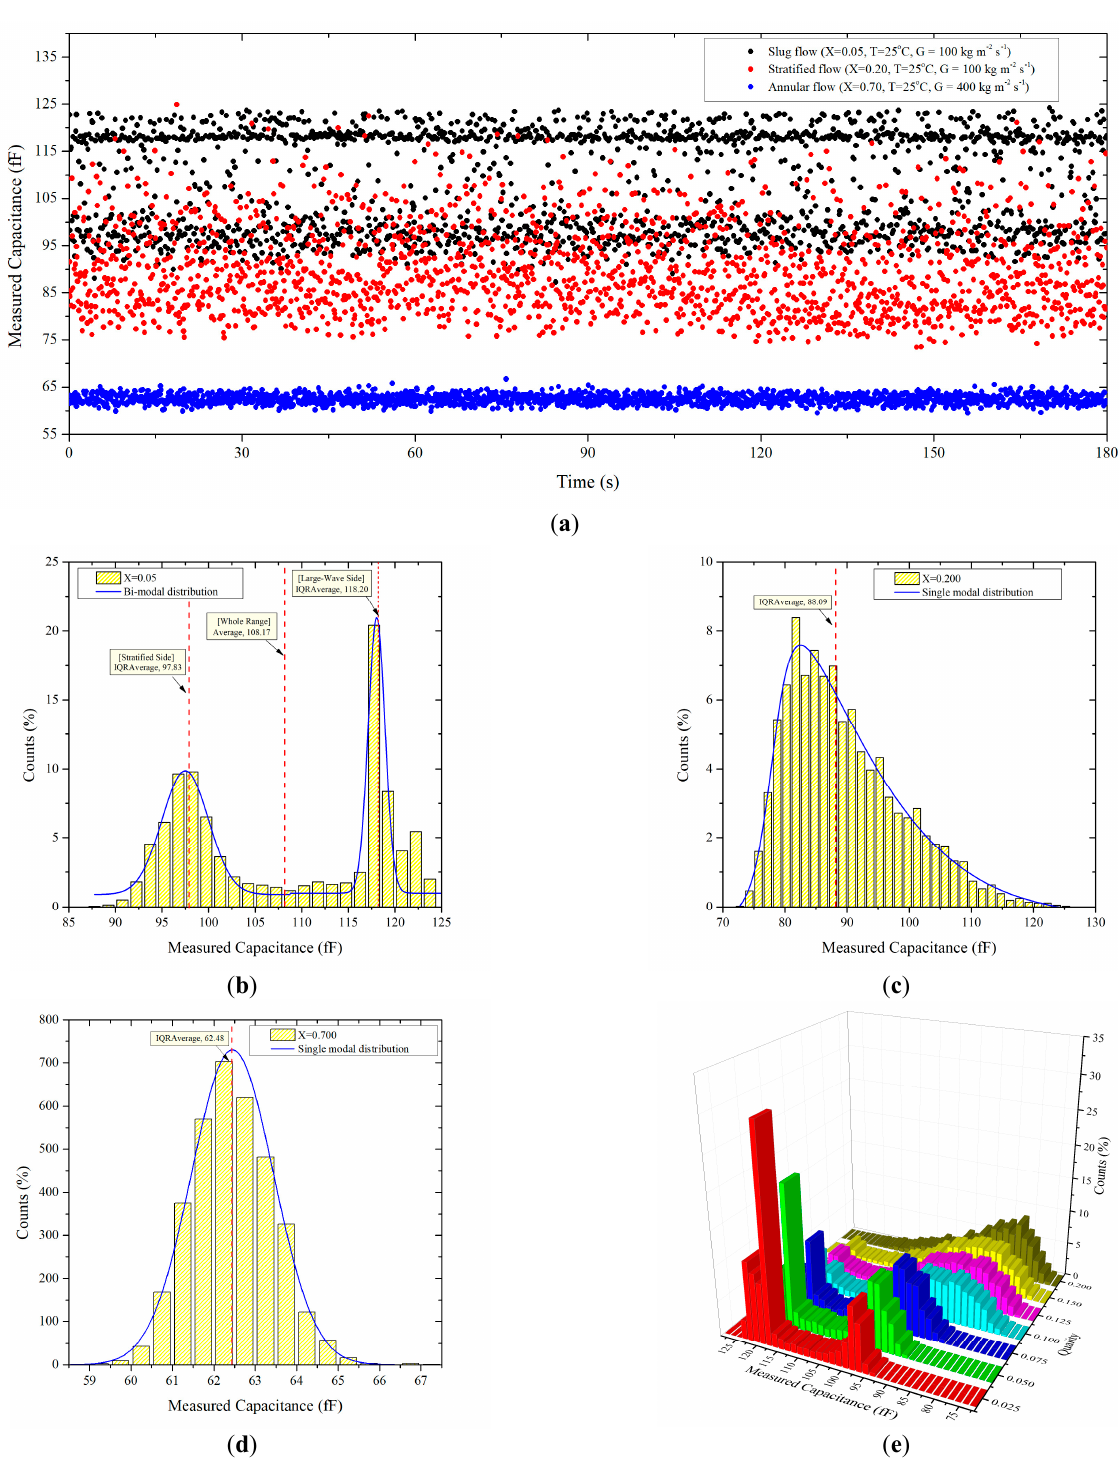
Figure 8. Typical distributions of capacitance measurement results for the R32 slug and stratified flow; ( a ) typical real-time capacitance histories of each flow pattern; ( b ) slug flow, 𝑥 = 0.05 , T = 25 °C, G = 100 kg m − 2 s − 1 ; ( c ) stratified flow, 𝑥 = 0.200 , T = 25 °C, G = 100 kg m − 2 s − 1 ; ( d ) annular flow, 𝑥 = 0.700 , T = 25 °C, G = 400 kg m − 2 s − 1 ; ( e ) measured capacitance profiles with respect to inlet vapor quality, T = 25 °C, G = 100 kg m − 2 s − 1 .